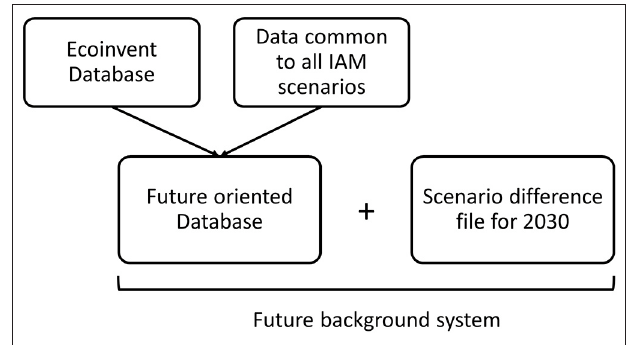
FIGURE 3 | A simplified representation of a future background system for the year 2030. Adapted from Steubing and de Koning